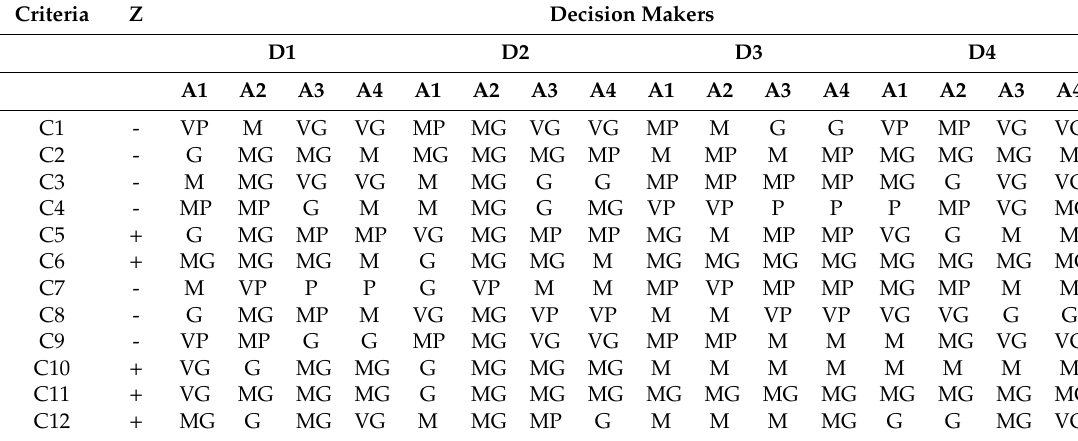
Table A2. Linguistic matrix of alternatives A1–A2–A3–A4.